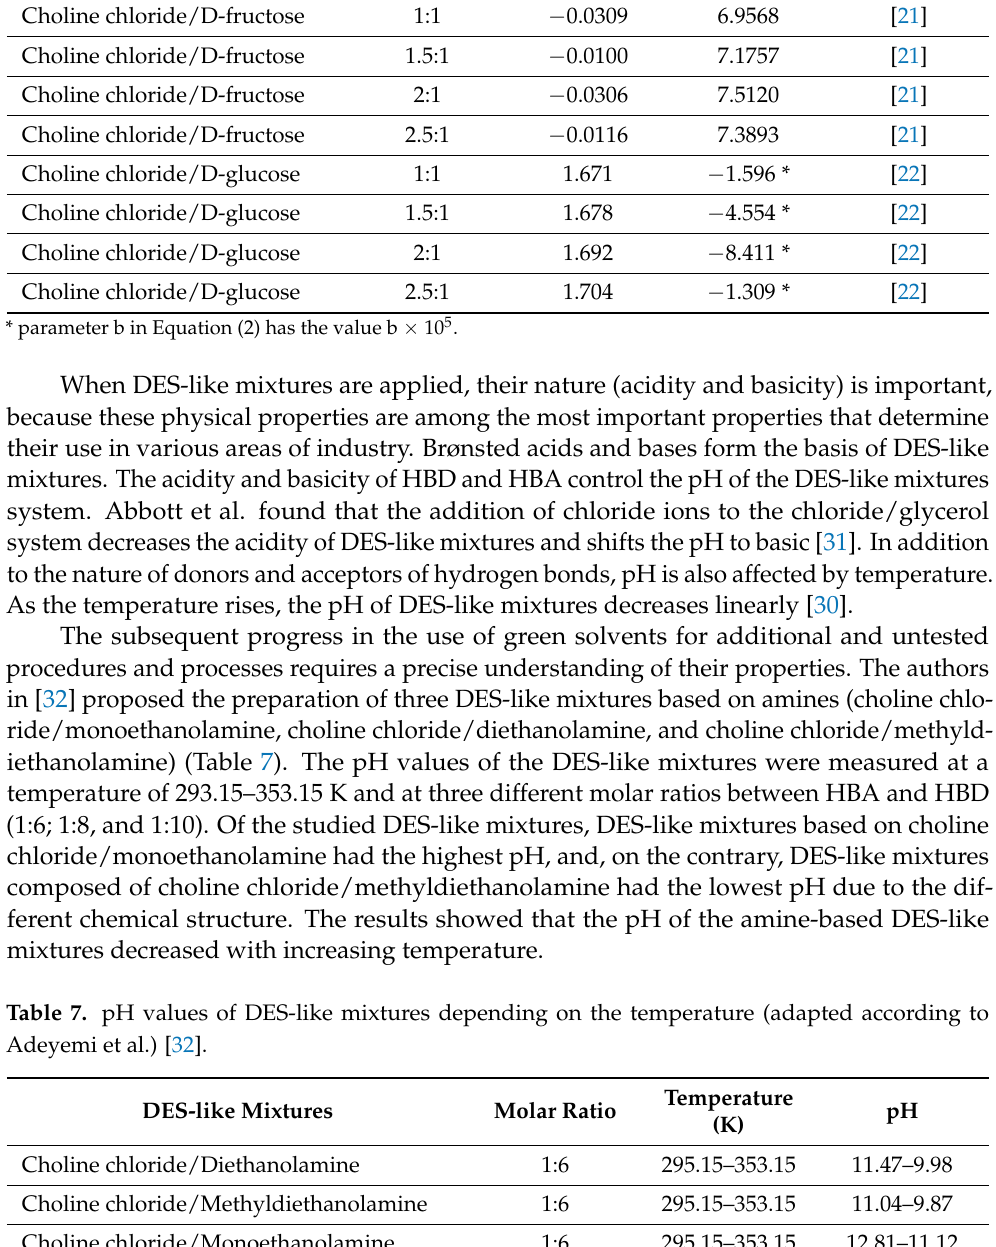
pH Molar Ratio Ref. a b/b × 10 5 *